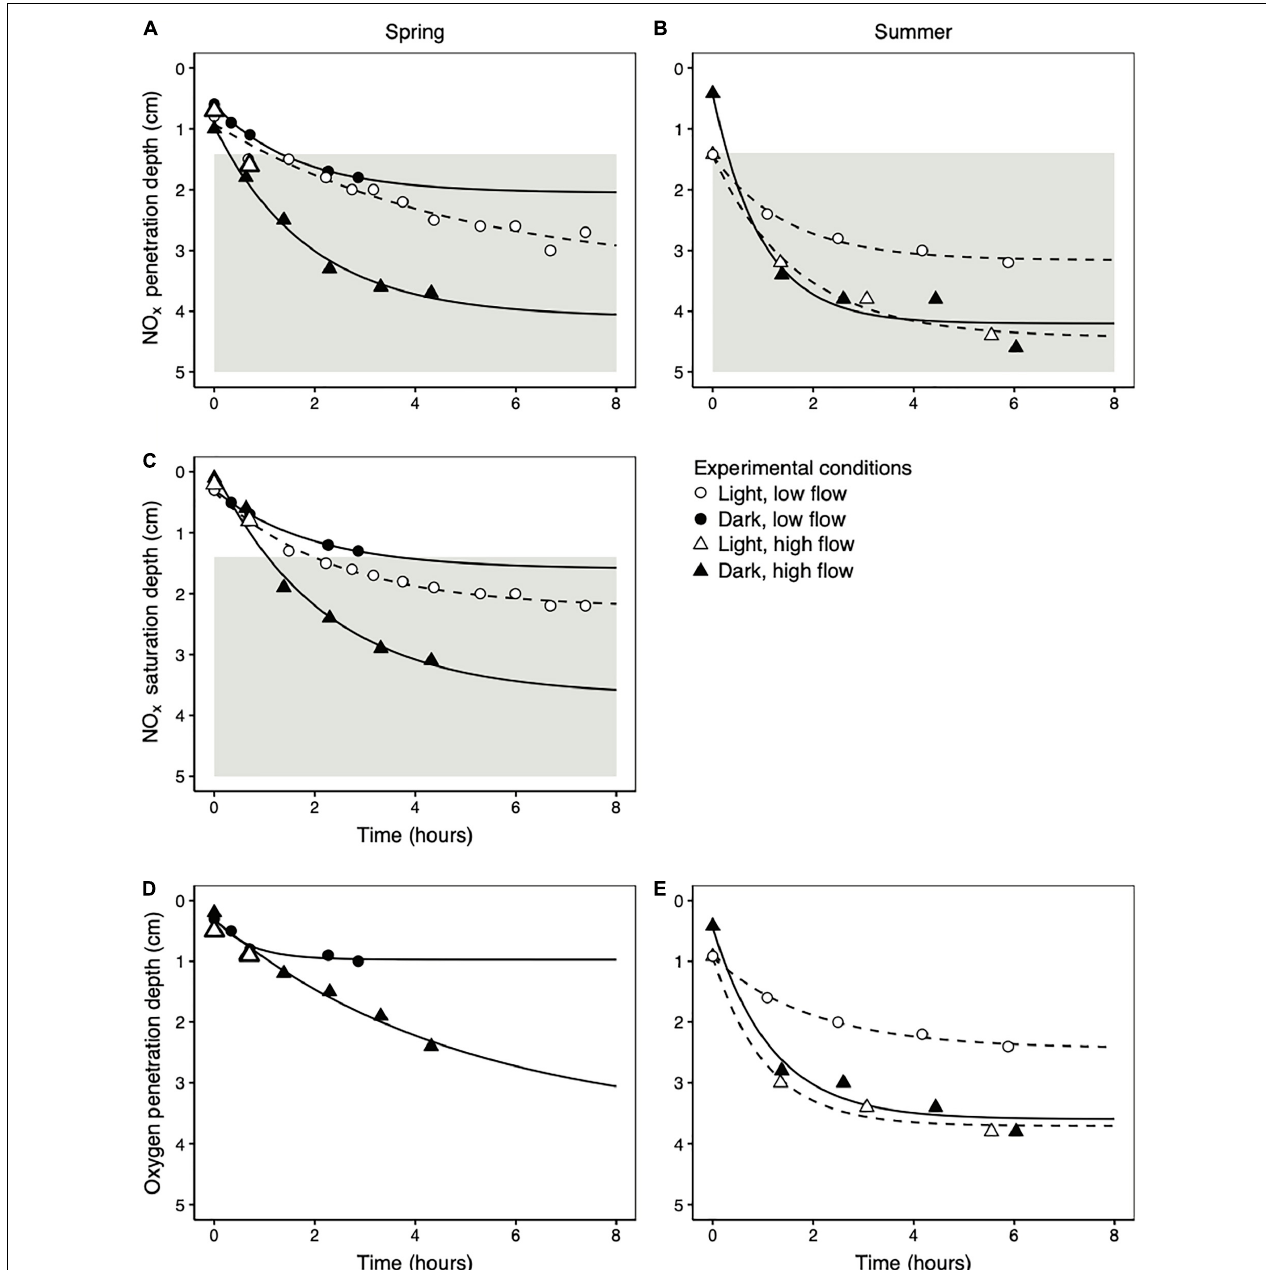
FIGURE 4 | The change in NO x penetration depths (A,B) , NO x saturation depths (the depth at which the NO x concentration falls below 7.8 µ mol L − 1 ) (C) , and oxygen penetration depths (D,E) as a function of time following the onset of porewater flow. Data from the spring are displayed in the left column (A,C,D) and data from the summer are displayed in the right column (B,E) . All summer profiles were measured in the same core. In the spring, low flow rate profiles were measured in one core and high flow rate profiles in a second, independent core. The lines represent asymptotic fits to the data according to Equation 7. The gray areas in (A–C) represent the deep depth interval over which potential denitrification rates reached their maximum (below 1.4 cm; Figure 2B